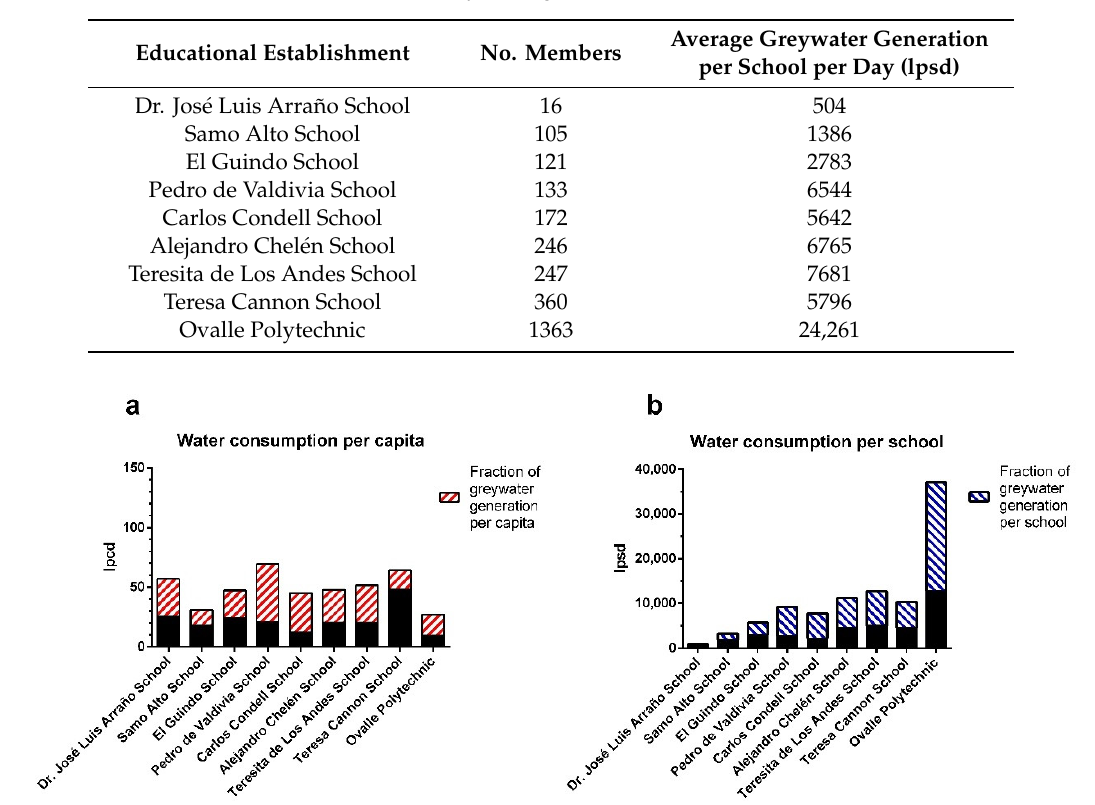
Table 2. Greywater generation in schools.